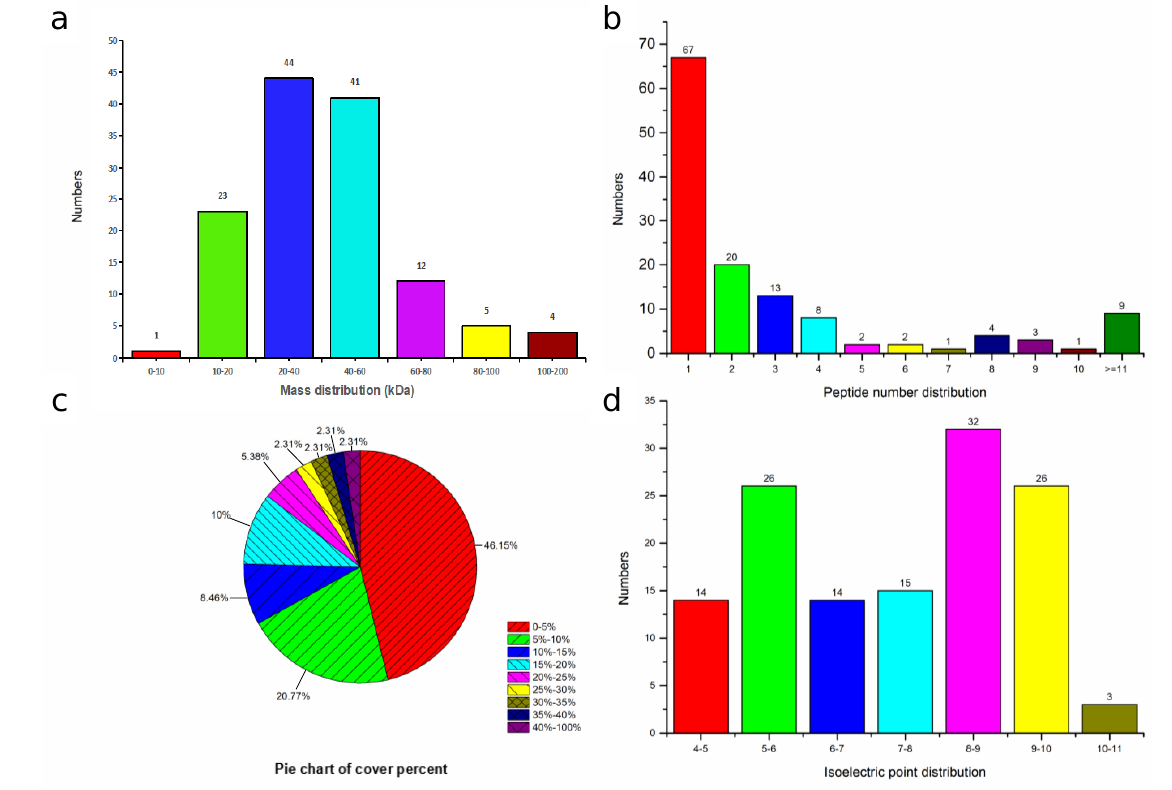
Figure 3. Overview of mass spectrometry data of 130 surface proteins extracted from Enterocytozoon hepatopenaei spores. ( a ) Molecular weight distribution. ( b ) Peptide number. ( c ) Peptide coverage (percent). ( d ) Statistical result of isoelectric point.